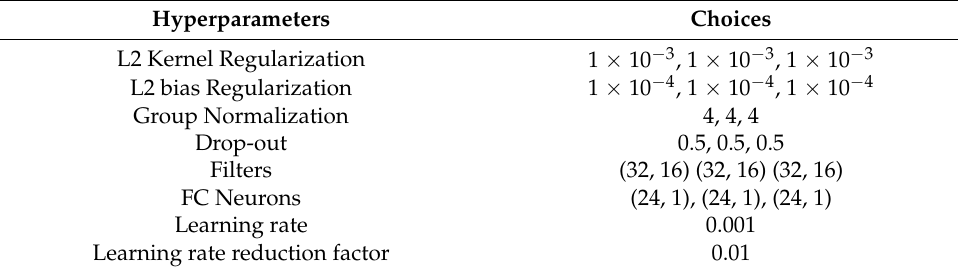
Table 1. Hyperparameter optimization of